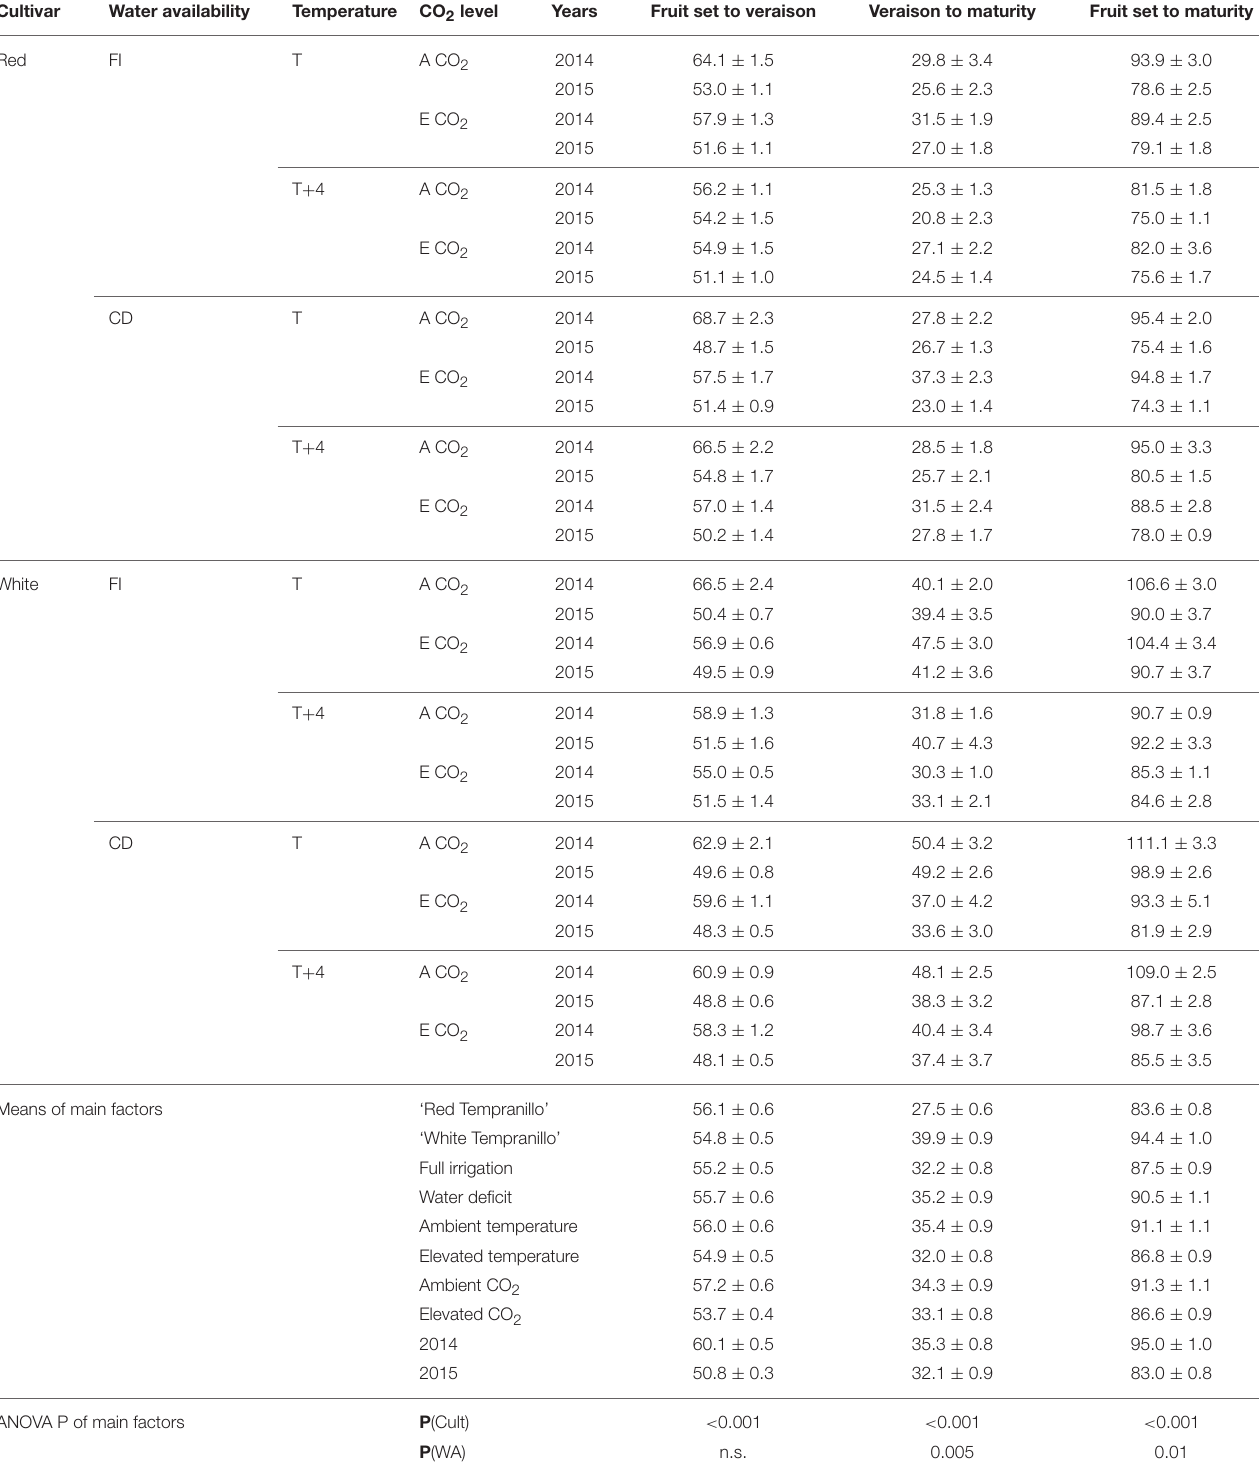
TABLE 2 | Days to complete phenological periods: fruit set to veraison, veraison to designated maturity and fruit set to designated maturity in ‘Red Tempranillo’ and ‘White Tempranillo’ grapevine grown under two water availability levels (FI, full irrigation or CD, cyclic drought), two temperature regimes (ambient temperature, T or ambient temperature + 4 ◦ C, T + 4 ◦ C) and two CO 2 concentrations (A CO 2 , ambient CO 2 , or E CO 2 , 700 µ L L − 1 CO 2